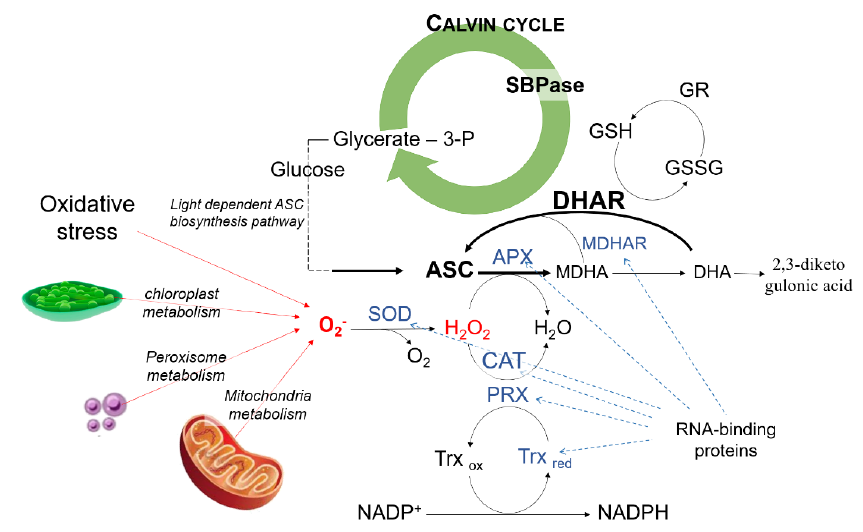
Figure 6. Plant antioxidant defense system. Reactive oxygen species (ROS) generated in the cell can be detoxified by the plant antioxidant system. The highly reactive and toxic superoxide ion (O 2 − ) can be dismutated by superoxide dismutase (SOD) into O 2 and H 2 O 2 . Catalases (CAT), peroxiredoxins (PRX), and peroxidases use H 2 O 2 as a cofactor. Ascorbate peroxidase (APX) uses ascorbate (ASC) as an electron donor to detoxify H 2 O 2 in a reaction that generates monodehydroascorbate (MDHA). MDHA can also undergo disproportionation into dehydroascorbate (DHA), which spontaneously decomposes to 2,3-diketogulonic acid. MDHA and DHA can be then restored to ASC by MDHA reductase (MDHAR) and DHA reductase (DHAR), respectively. The latter is a glutathione (GSH)-dependent enzyme and therefore uses GSH. Glutathione reductase (GR) restores the oxidized glutathione (GSSG) to its reduced form. Thioredoxins (Trx) are nicotinamide adenine dinucleotide phosphate + -dependent enzymes which regenerate PRXs. The possible involvement of the sedoheptulose-1,7-bisphosphatase (SBPase) and the RNA-binding proteins in the complex ascorbate regulation network is also presented in blue; more details are given in the discussion section.